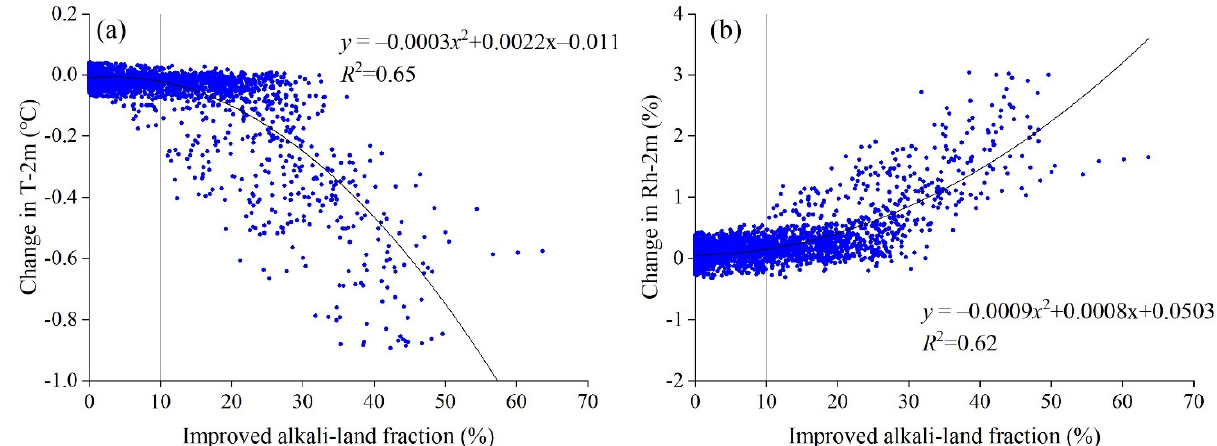
Figure 7. Scatter plots of cell-based changes (SEN minus CTL) in the improved saline-alkali land fraction and changes in simulated ( a ) surface air temperature (T-2 m) and ( b ) relative humidity (Rh-2 m) for JJAS (June-July August-September) over western Jilin.